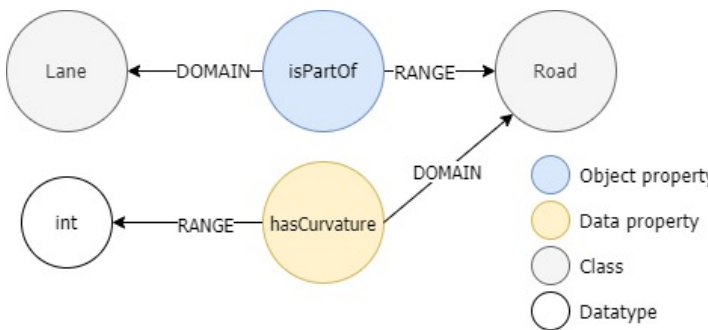
Figure 5. Object property and data property triple examples represented as a graph.